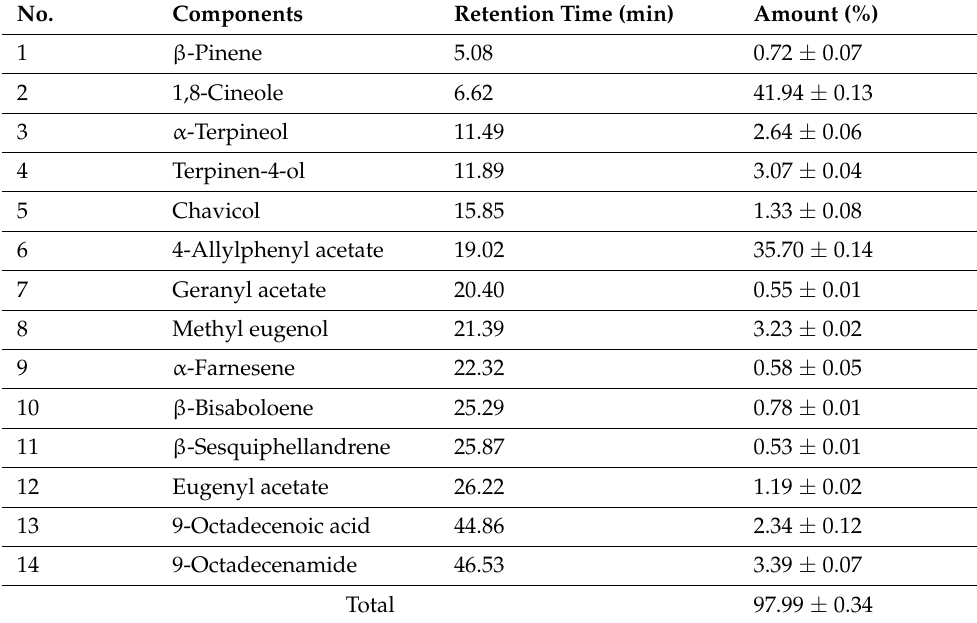
Table 1. Chemical constituents in